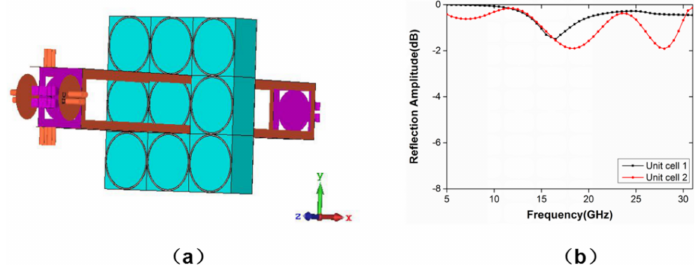
Figure 2. ( a ) The unit cell simulation model based on the Floquet method and ( b ) reflection amplitude of the unit cells.